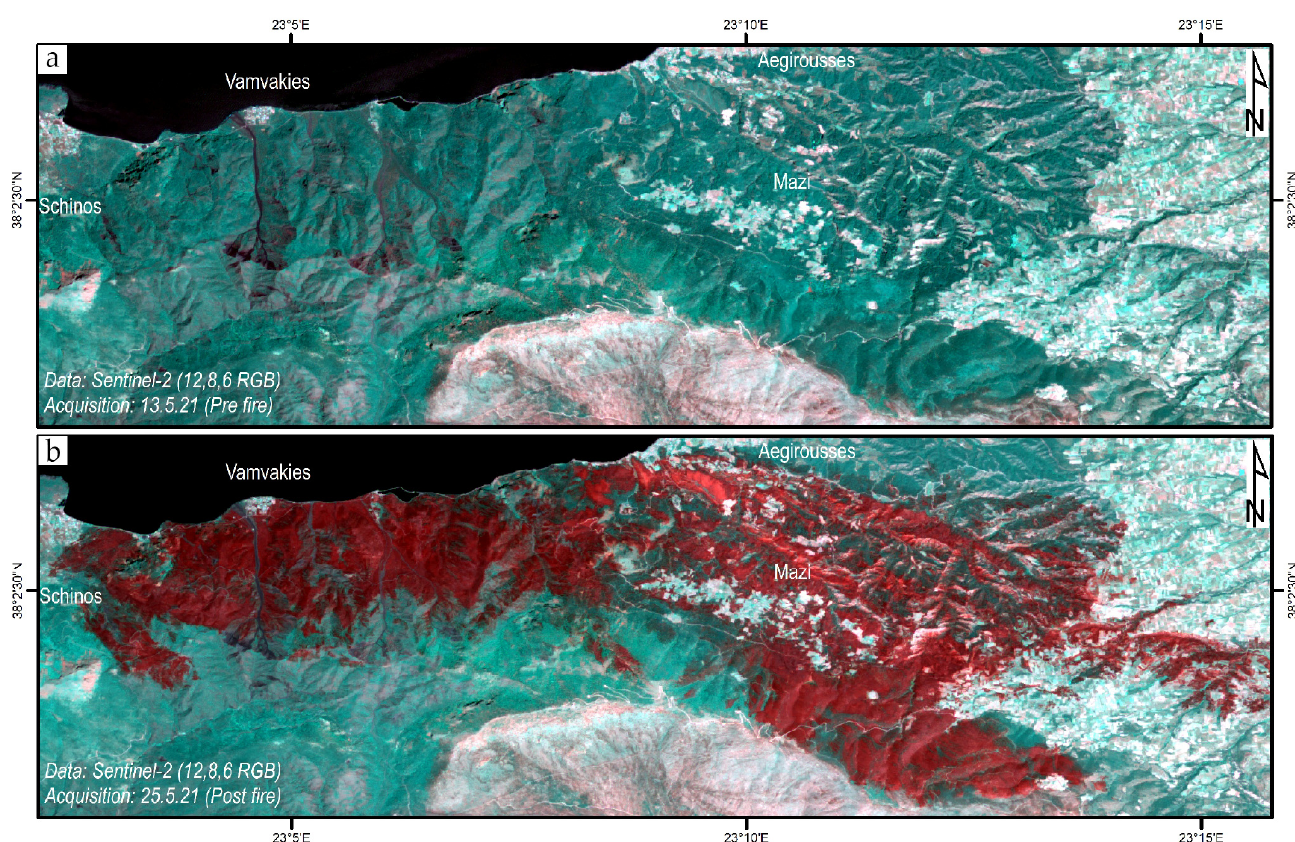
Figure 3. Sentinel-2A satellite images of the study area ( a ) on 13 May 2021 before the fire and ( b ) on 25 May 2021 after the fire. The dark red colors show the burnt area.